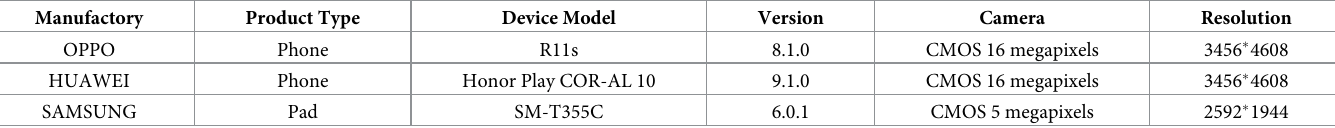
Table 2. Descriptions of test